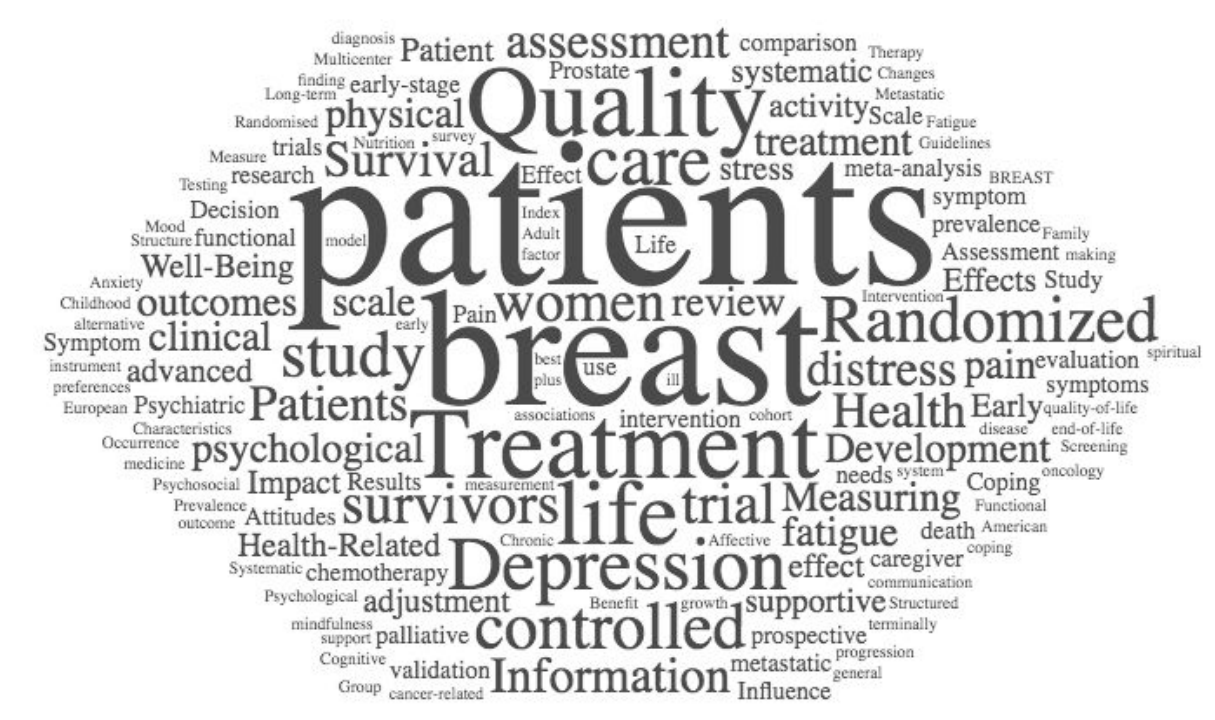
Figure 2. Word cloud of the words used in the titles of the 100 included studies.